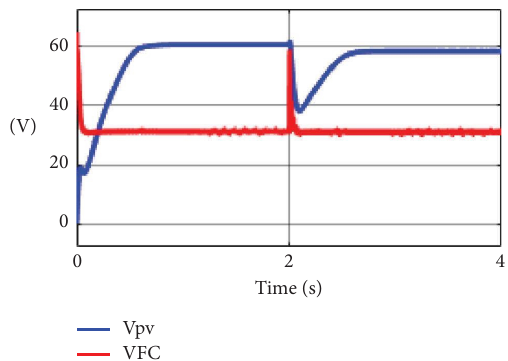
Figure 21: V PV and V FC in the second operation